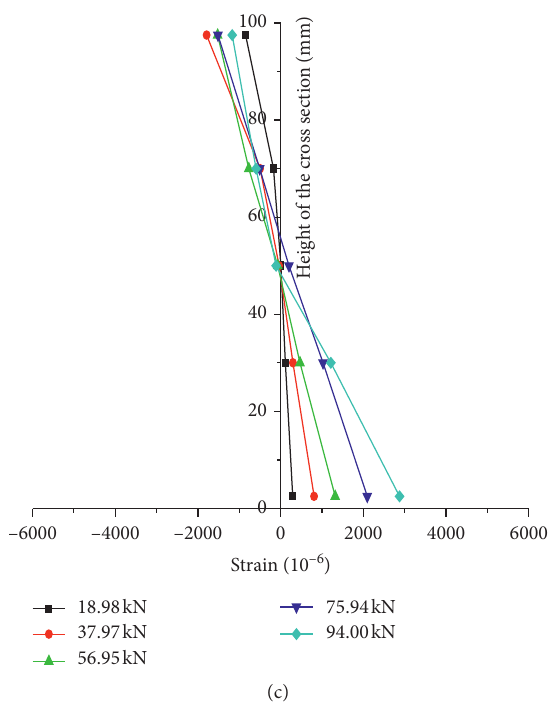
Figure 15: Section strain curves of beams under a prestressing force of 7kN. (a) Section strain curves of L L A5(2) . (c) Section strain curves of L A6(1) .